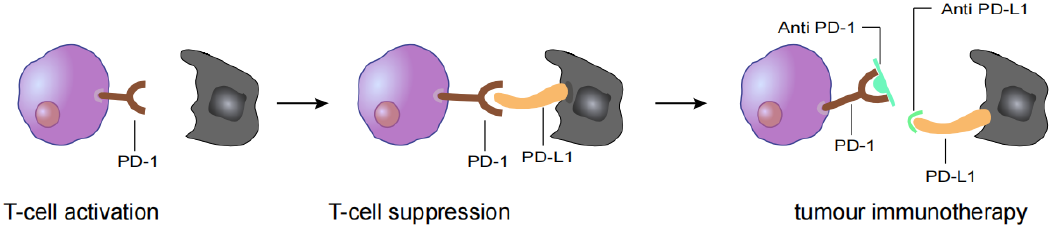
Figure 1. T cell activation is suppressed by the interaction between programmed death 1 (PD-1) on T cells and PD-L1 on tumour cells. Antibody drugs for cancer immunotherapy bind to PD-1 or PD-L1, blocking the PD-1/PD-L1 interaction.